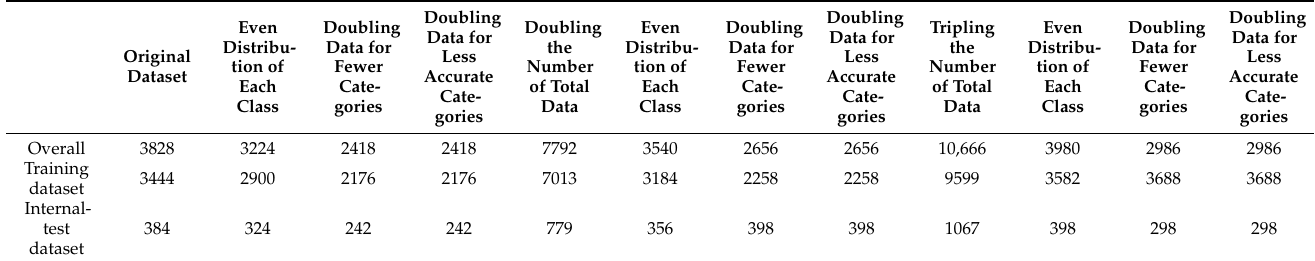
Table 2. Training and internal-test dataset distribution in each input dataset.